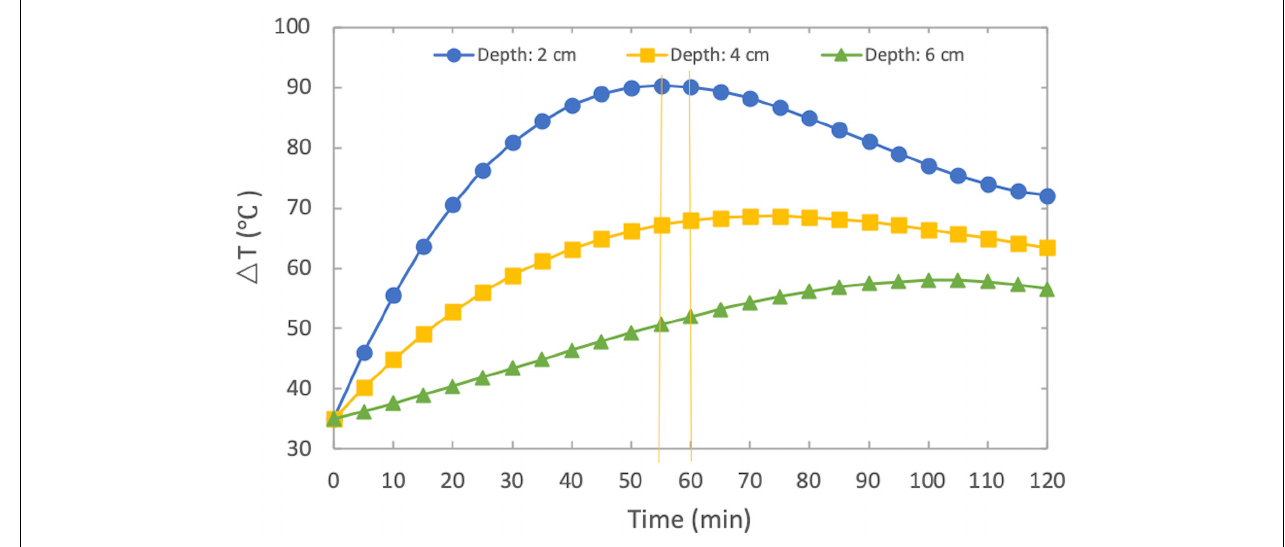
FIGURE 5 | Temperature curves at each depth of cold recycled mixture when HMA paving.